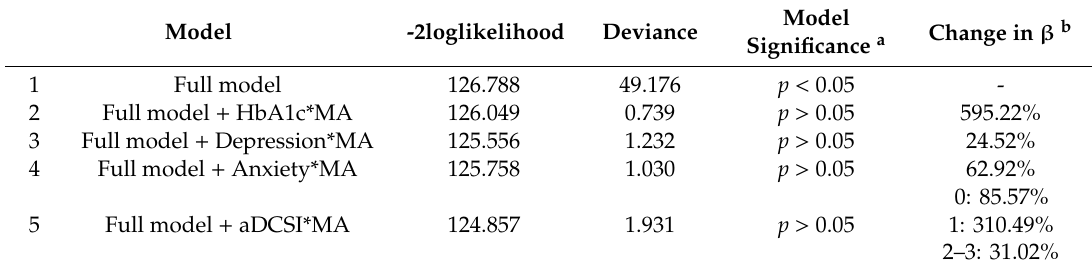
Table 4. Interaction and e ff ect modification of medication